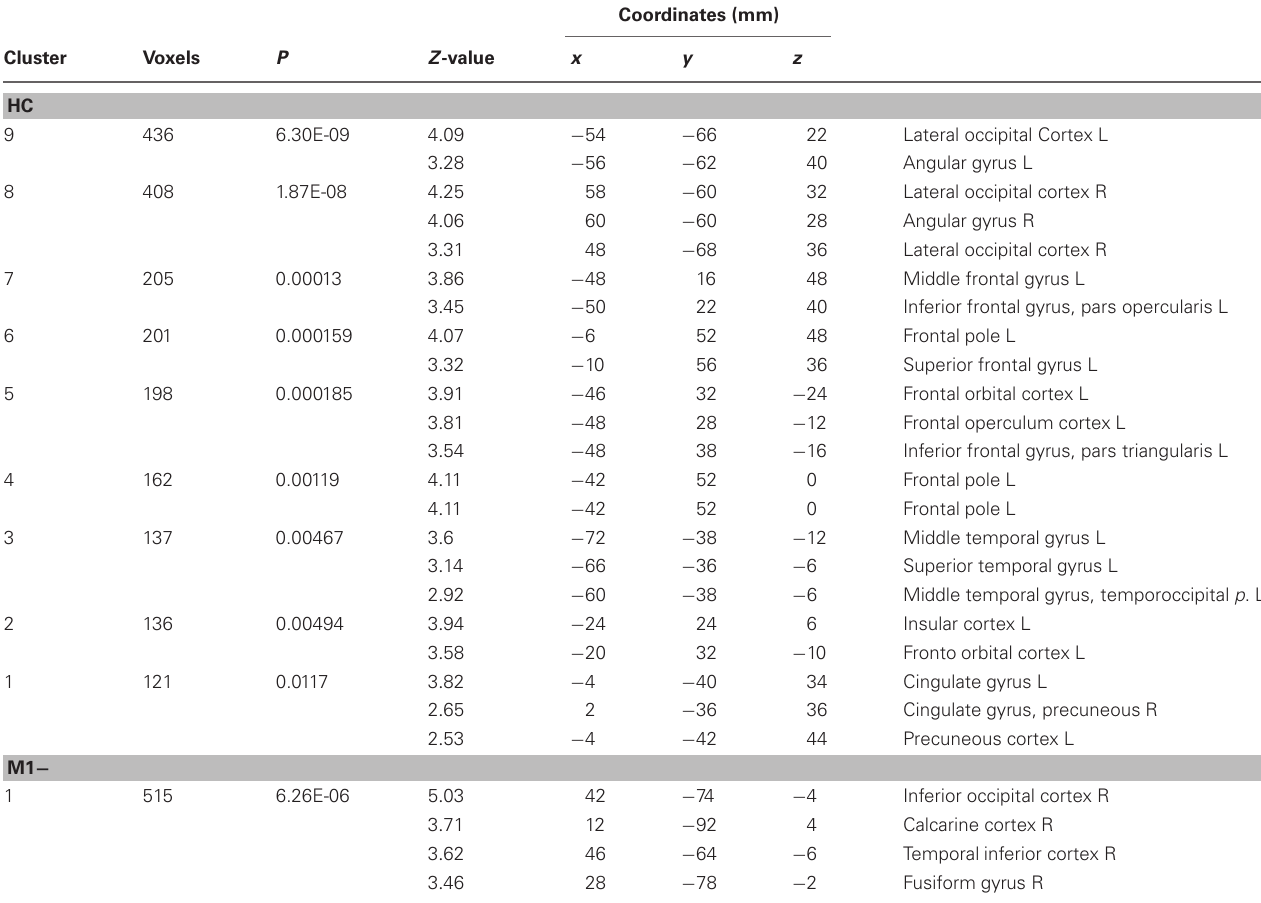
Table 6 | Brain regions showing significant increases of connectivity to the left Boca’s area during the verb generation task vs. rest as revealed by the PPI